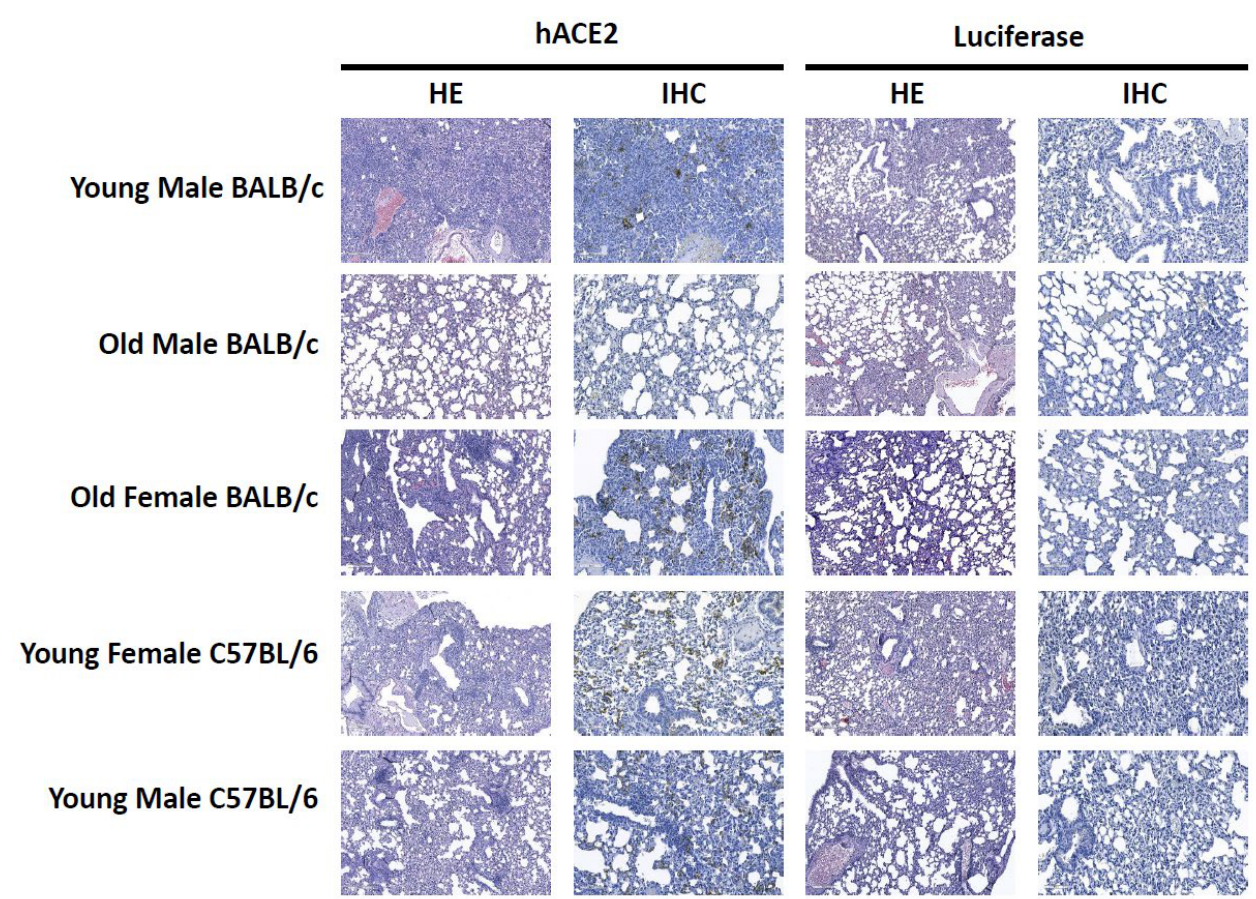
Figure 3. Presence of microscopic lesions (HE, Hematoxylin/eosin stain) and antigen distribution by immunohistochemistry (IHC) in tissues of SARS-CoV-2 infected mice. Mice of different sex and strain were transduced with either hACE2-AAV6.2FF or Luciferase-AAV6.2FF and inoculated with SARS-CoV-2. The magnification is 10× for H&E and IHC. Scale bars = 100 um.